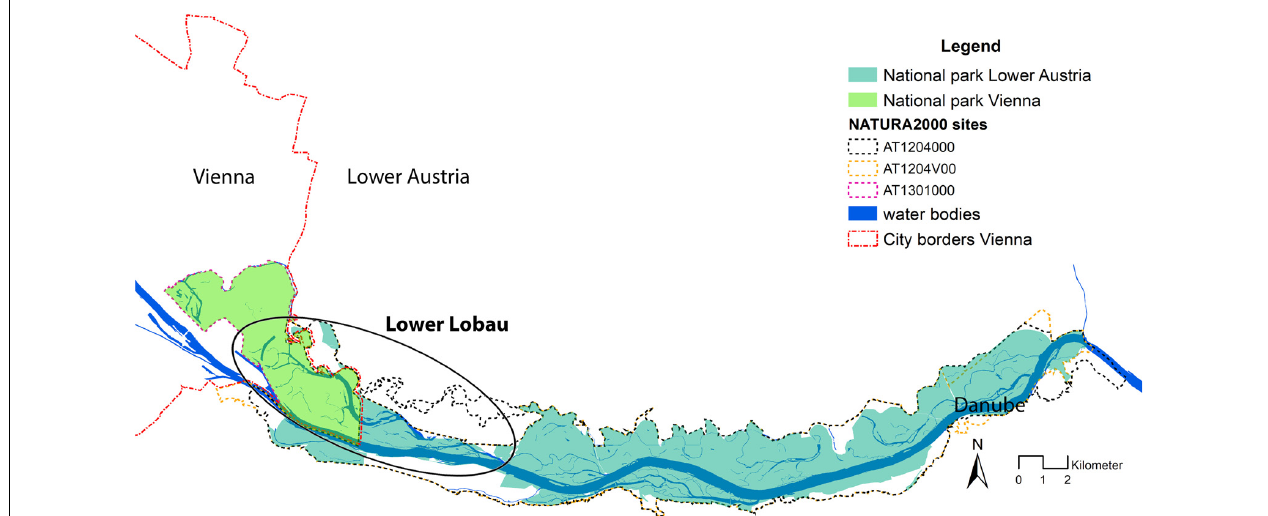
FIGURE 1 | Map of the study area Lower Lobau, showing its location within the two Natura 2000 sites in Vienna (Site code 1301000) and Lower Austria (Site codes 1204000 and 1204V00) and as part of the National park “Danube wetlands” (parts in Vienna and Austria marked in different